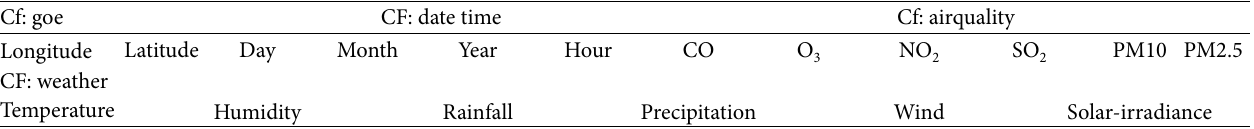
Table 3: Hbase table structure and design.